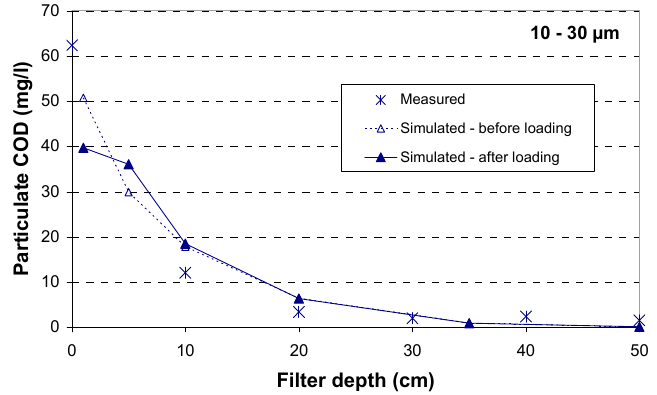
Figure 8. Comparison of measured and simulated particulate COD for the 10–30 μ m particle class (adapted from [49]).